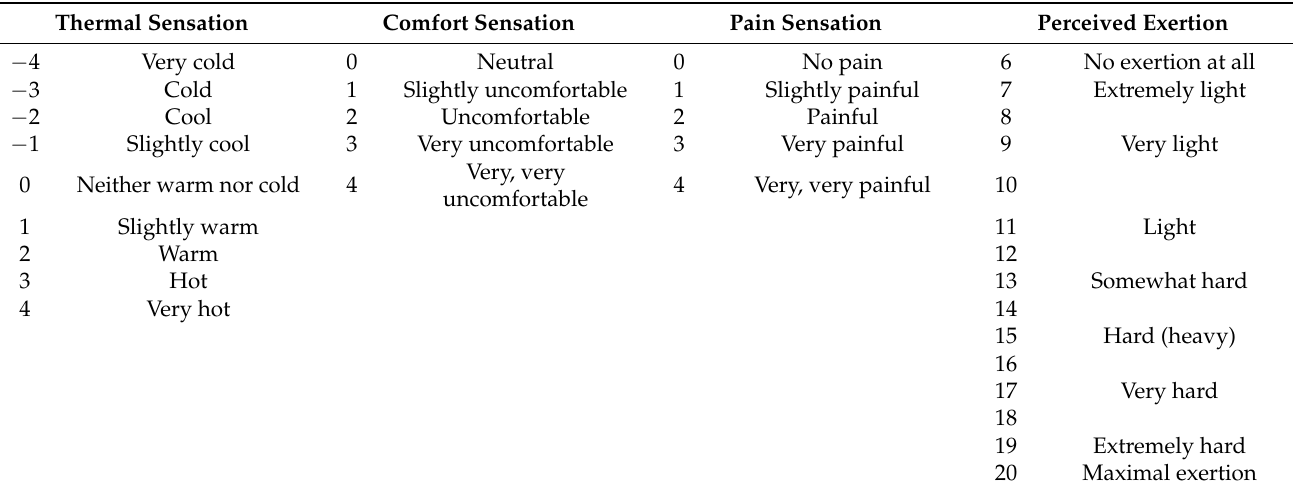
Table 2. Subjective responses scales.